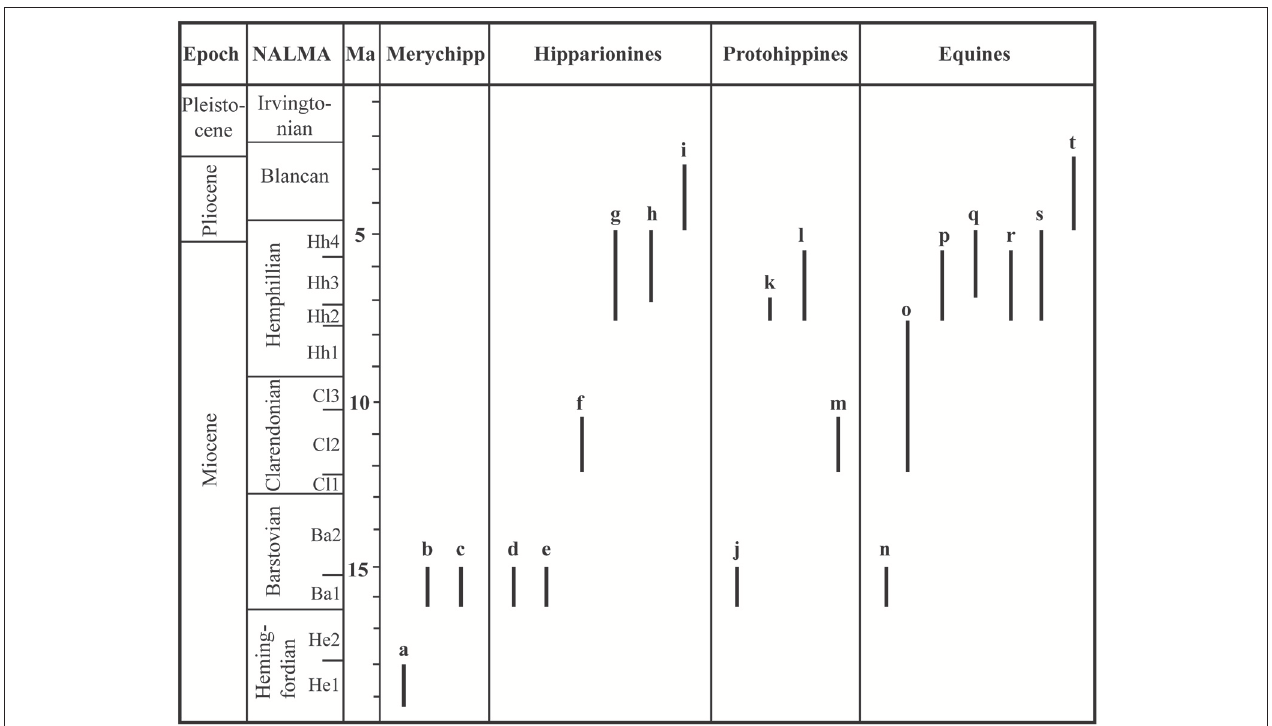
FIGURE 2 | Temporally calibrated record of Equinae from the Mexican Neogene. Merychippines (Merychipp): a, “Merychippus” sp.; b, “M.” cf. primus ; c, “M.” cf. sejunctus . Hipparionines: d, Merychippus californicus ; e, Cormohipparion aff. quinni ; f, Hipparion sp.; g, Neohipparion eurystyle ; h, Nannipus aztecus ; i,